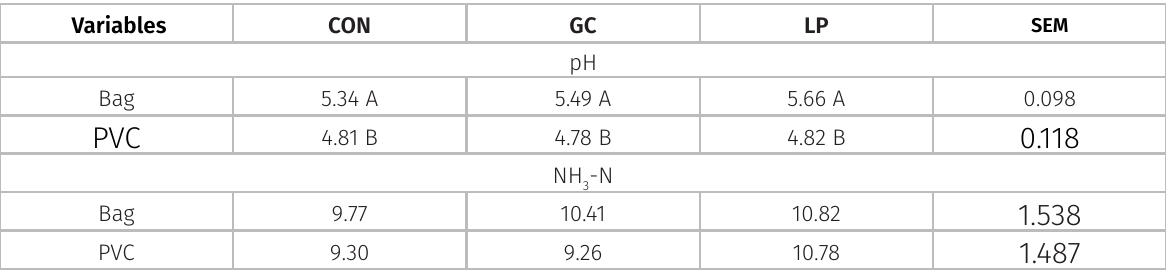
Table V. Effects of additives and silo type on pH and ammoniacal nitrogen (NH